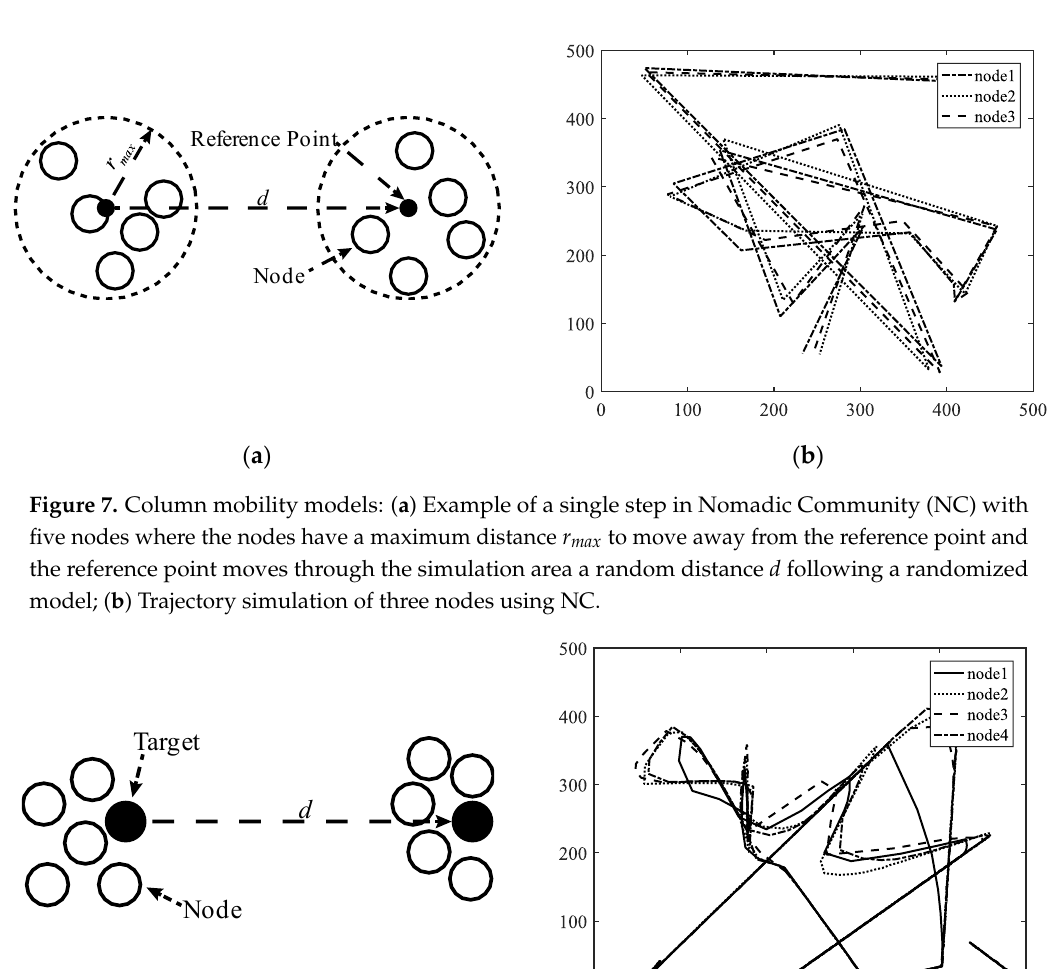
move through the simulation area and each node moves randomly around its reference point.